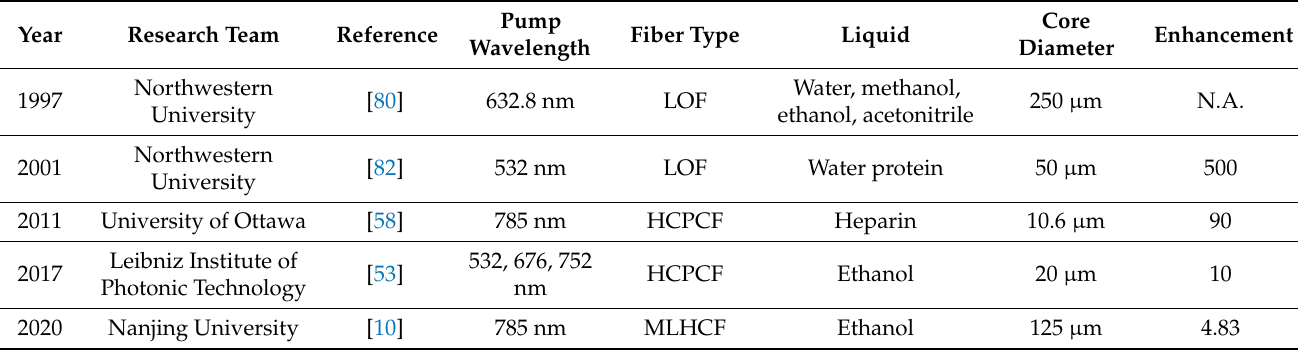
Table 4. Examples of liquid Raman spectroscopy with